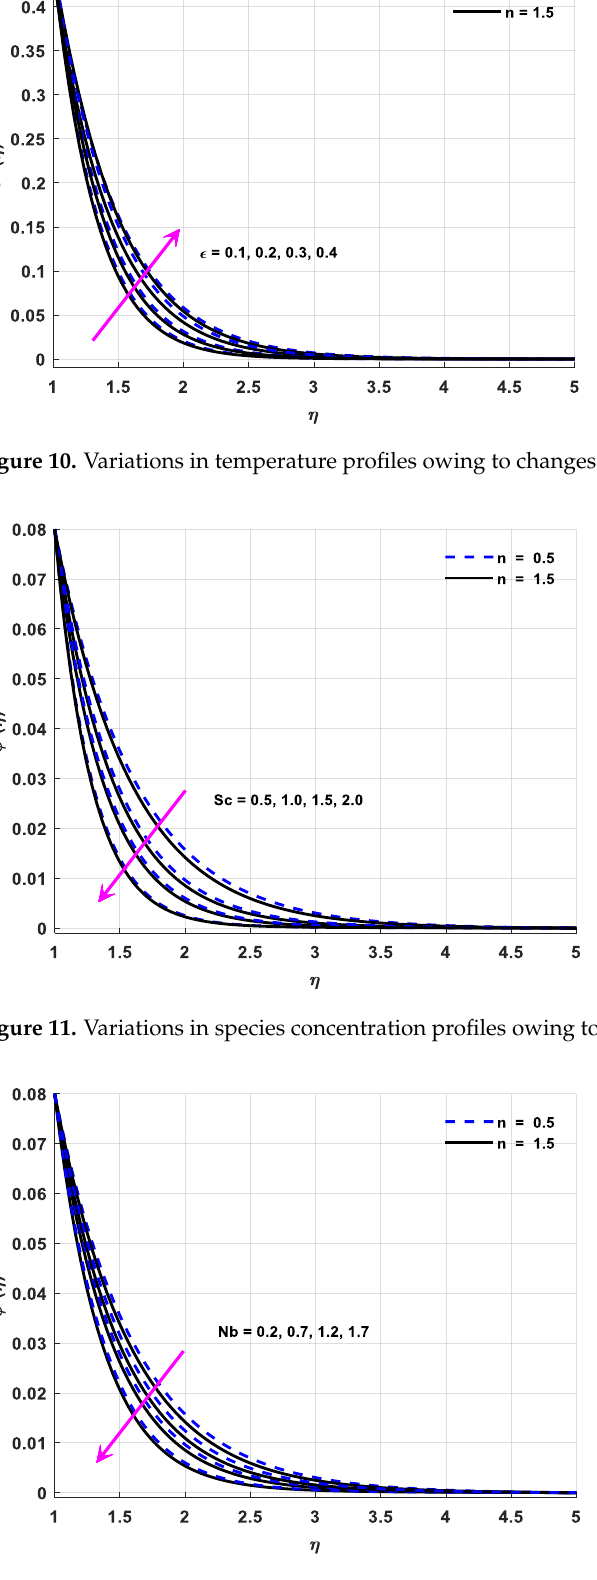
Figure 12. Variations in species concentration profiles owing to changes in Nb .